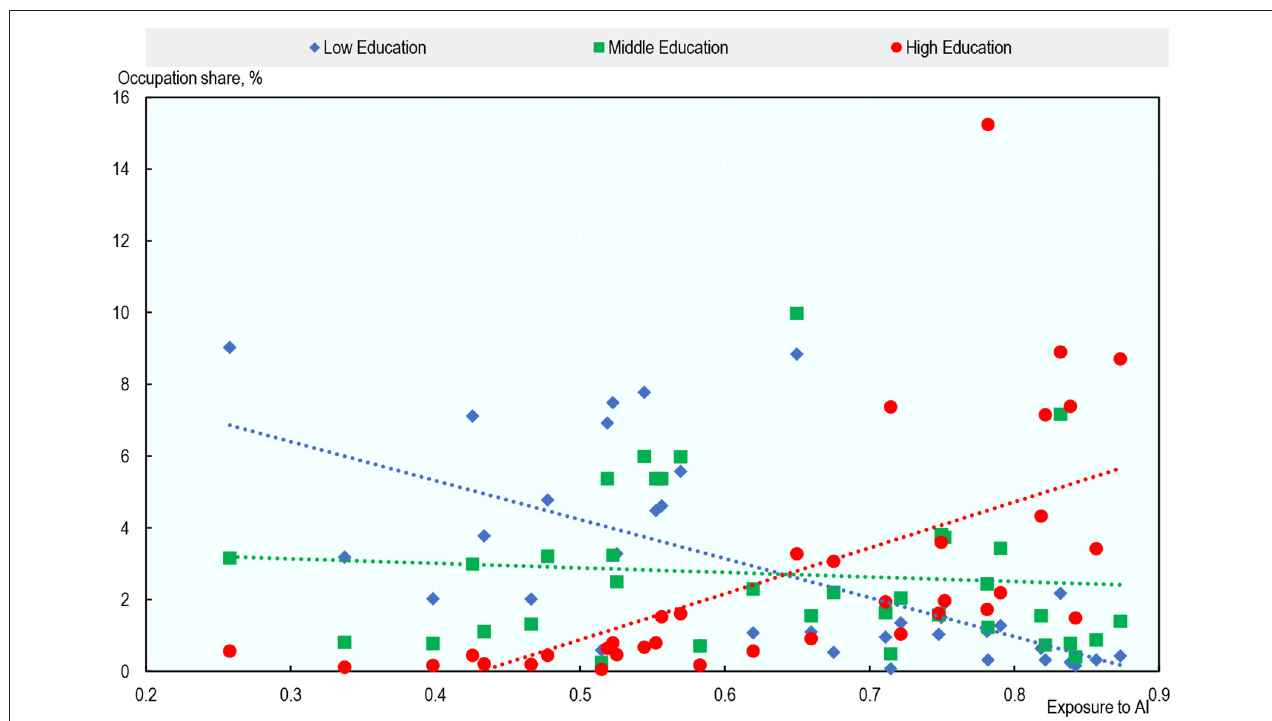
FIGURE 9 | Highly educated workers are disproportionately exposed to AI. Average share of workers with low, medium or high education within occupations vs. average exposure to AI, across countries (2012). For each education group, occupation shares represent the share of workers of that group in a particular occupation. Each dot reports the unweighted average across the 23 countries analyzed of the share of workers with a particular education in an occupation. Authors’ calculations using data from the European Union Labor Force Survey (EU-LFS), the Mexican National Survey of Occupation and Employment (ENOE), the US Current Population Survey (US-CPS) PIAAC, and Felten et al.